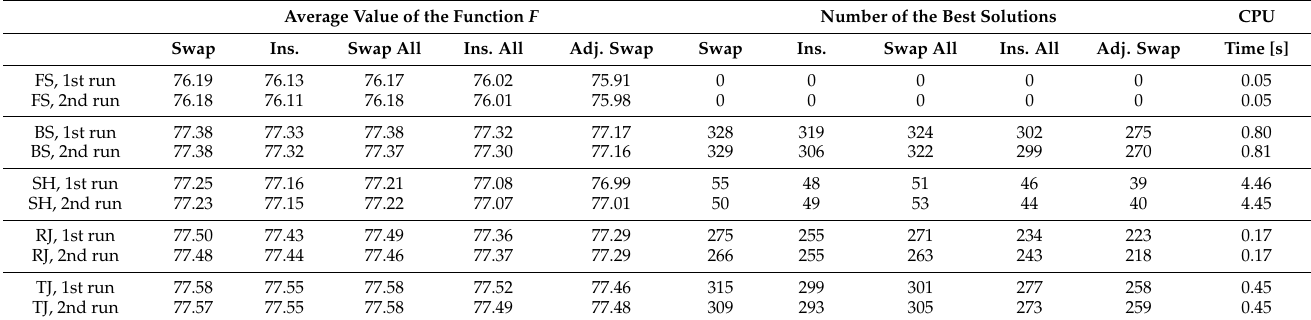
Table 1. Results of the experiments—J30